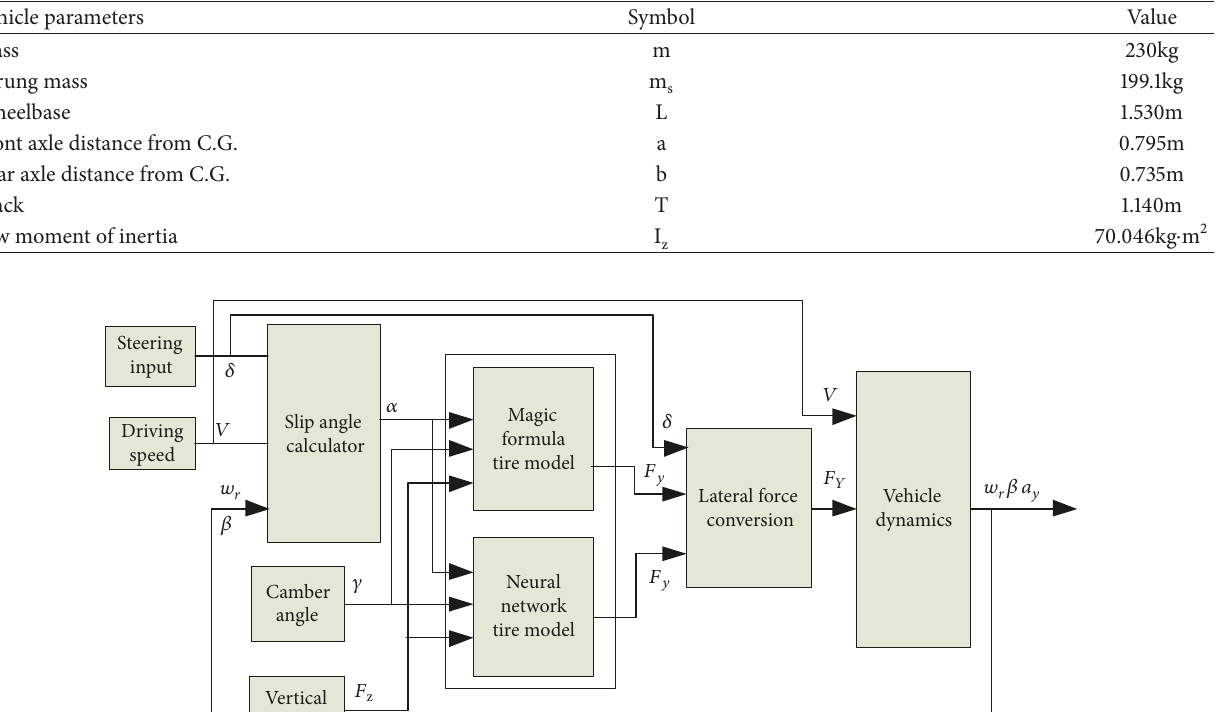
Table 1: Specifications of the FSAE race car.